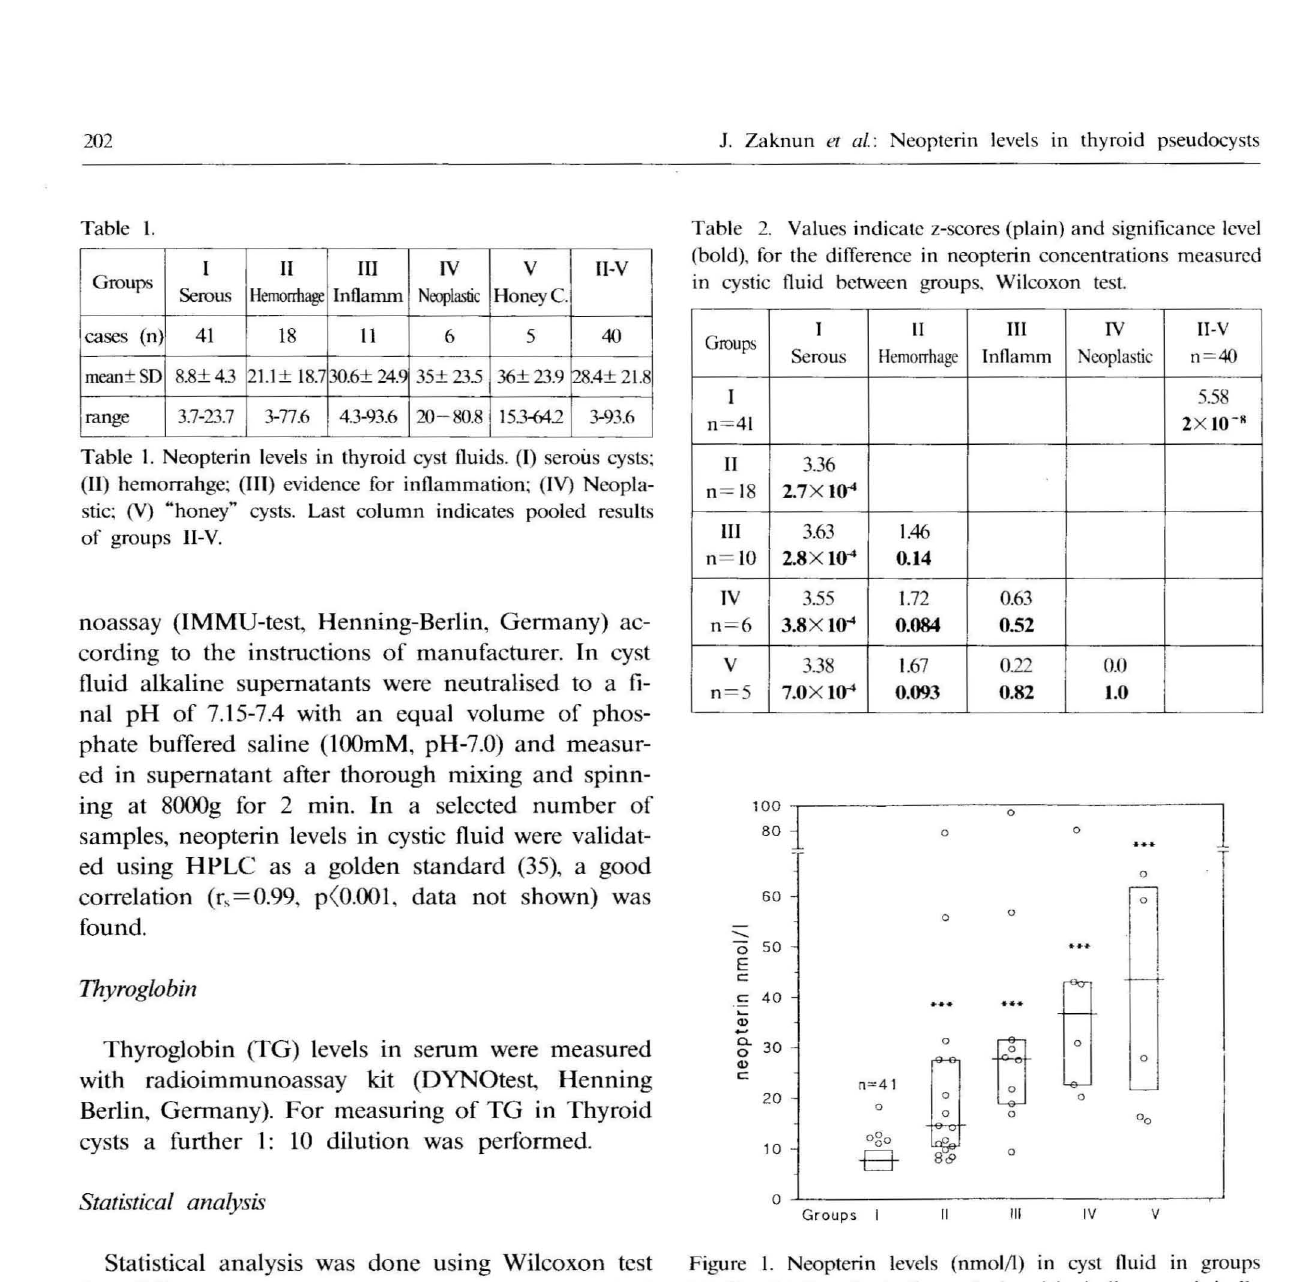
Table 1. Neopterin levels in thyroid cyst fluids. (I) serous cysts; (II) hemorrahge; (Ill) evidence for inflammation; (IV) Neopla stic; (V) "honey" cysts. Last column indicates pooled results of groups II-V.